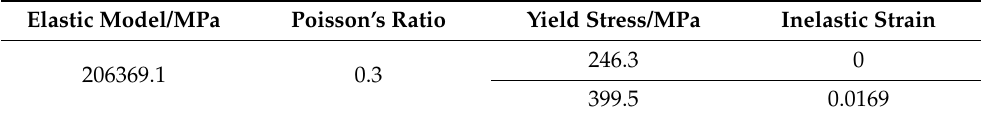
Table 2. Parameters of section